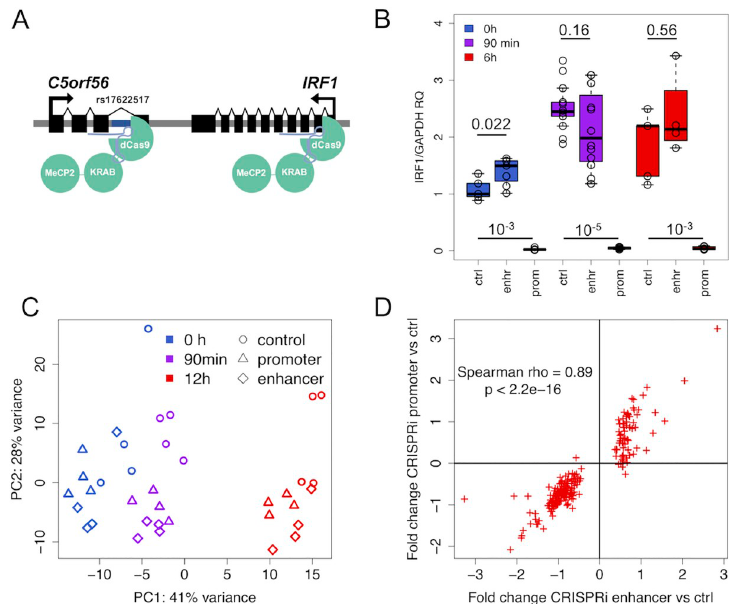
Fig 2. CRISPRi silencing. A) Illustration of CRISPRi silencing of the IRF1 promoter (right) and the putative enhancer locus at rs17622517 (left); B) qRT-PCR of IRF1 with promoter and enhancer silencing in THP1 cells; C) principal component analysis of gene expression under the different LPS and CRISPRi conditions; D) The correlation of expression fold changes for promoter and enhancer silencing at 12h LPS, shown for 225 genes that are significantly differentially expressed by enhancer